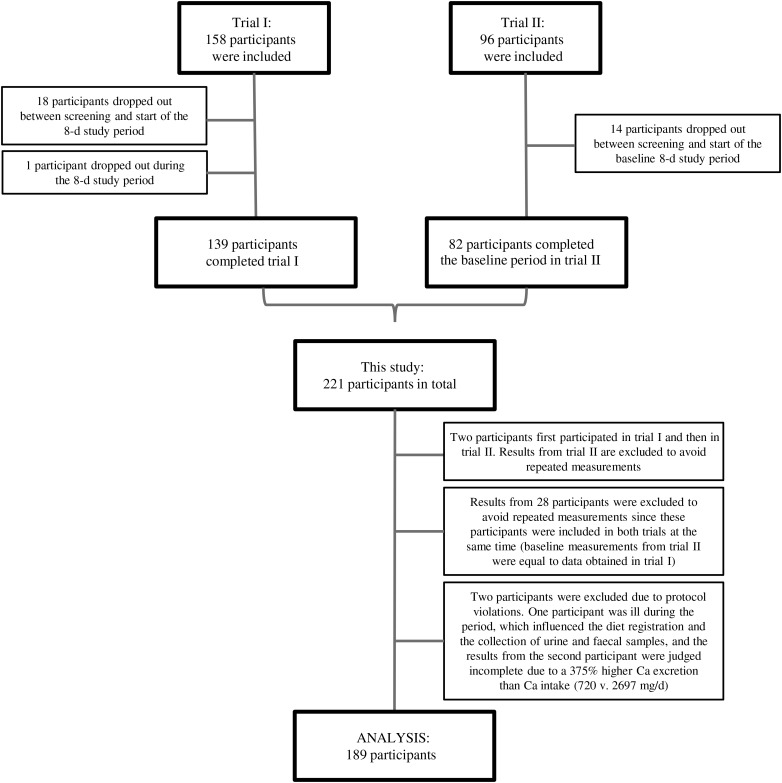
Flow chart. A total of 158 and ninety-six participants were recruited to trials I and II, respectively. In all, eighteen participants in trial I and fourteen participants in trial II dropped out before the 8-d data collection period started and one participant in trial I dropped out during the data collection period. Hence, 221 participants completed the studies. Before data analysis, thirty participants were excluded to avoid repeated measurement from those who participated in both studies and two participants were excluded due to protocol violation.